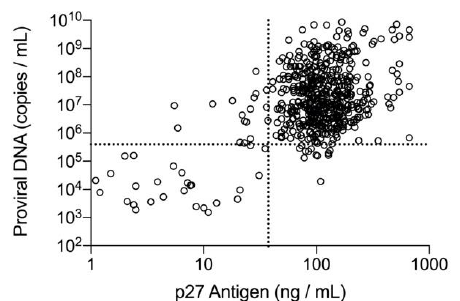
Figure 1. Samples with concordant positive results for p27 antigen by microtiter plate enzyme-linked immunosorbent assay (ELISA) and proviral DNA by real-time polymerase chain reaction (PCR) are plotted relative to the cutoff values established by the receiver operating characteristic (ROC) analysis. Results from 569 samples obtained from enrollment to 6 months are shown. Horizontal dashed line for the proviral DNA is placed at 4.0 × 10 5 copies/mL. Vertical dashed line for the log of p27 antigen concentration is placed at 37.5 ng/mL.